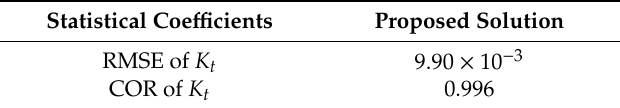
H 0.2 m, i K for the proposed t